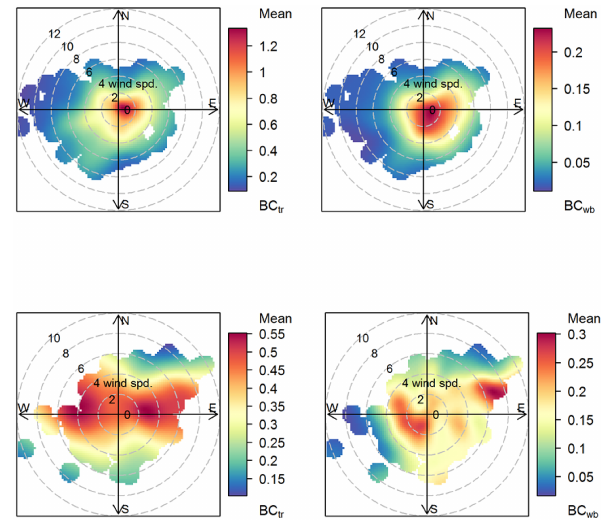
Figure 8. Polar plots of CPF analysis (90th percentile) for the BC concentrations at 880nm measured with a 2W AE at the sites during the winter campaign. Wind speed (wind spd) is in ms − 1 .